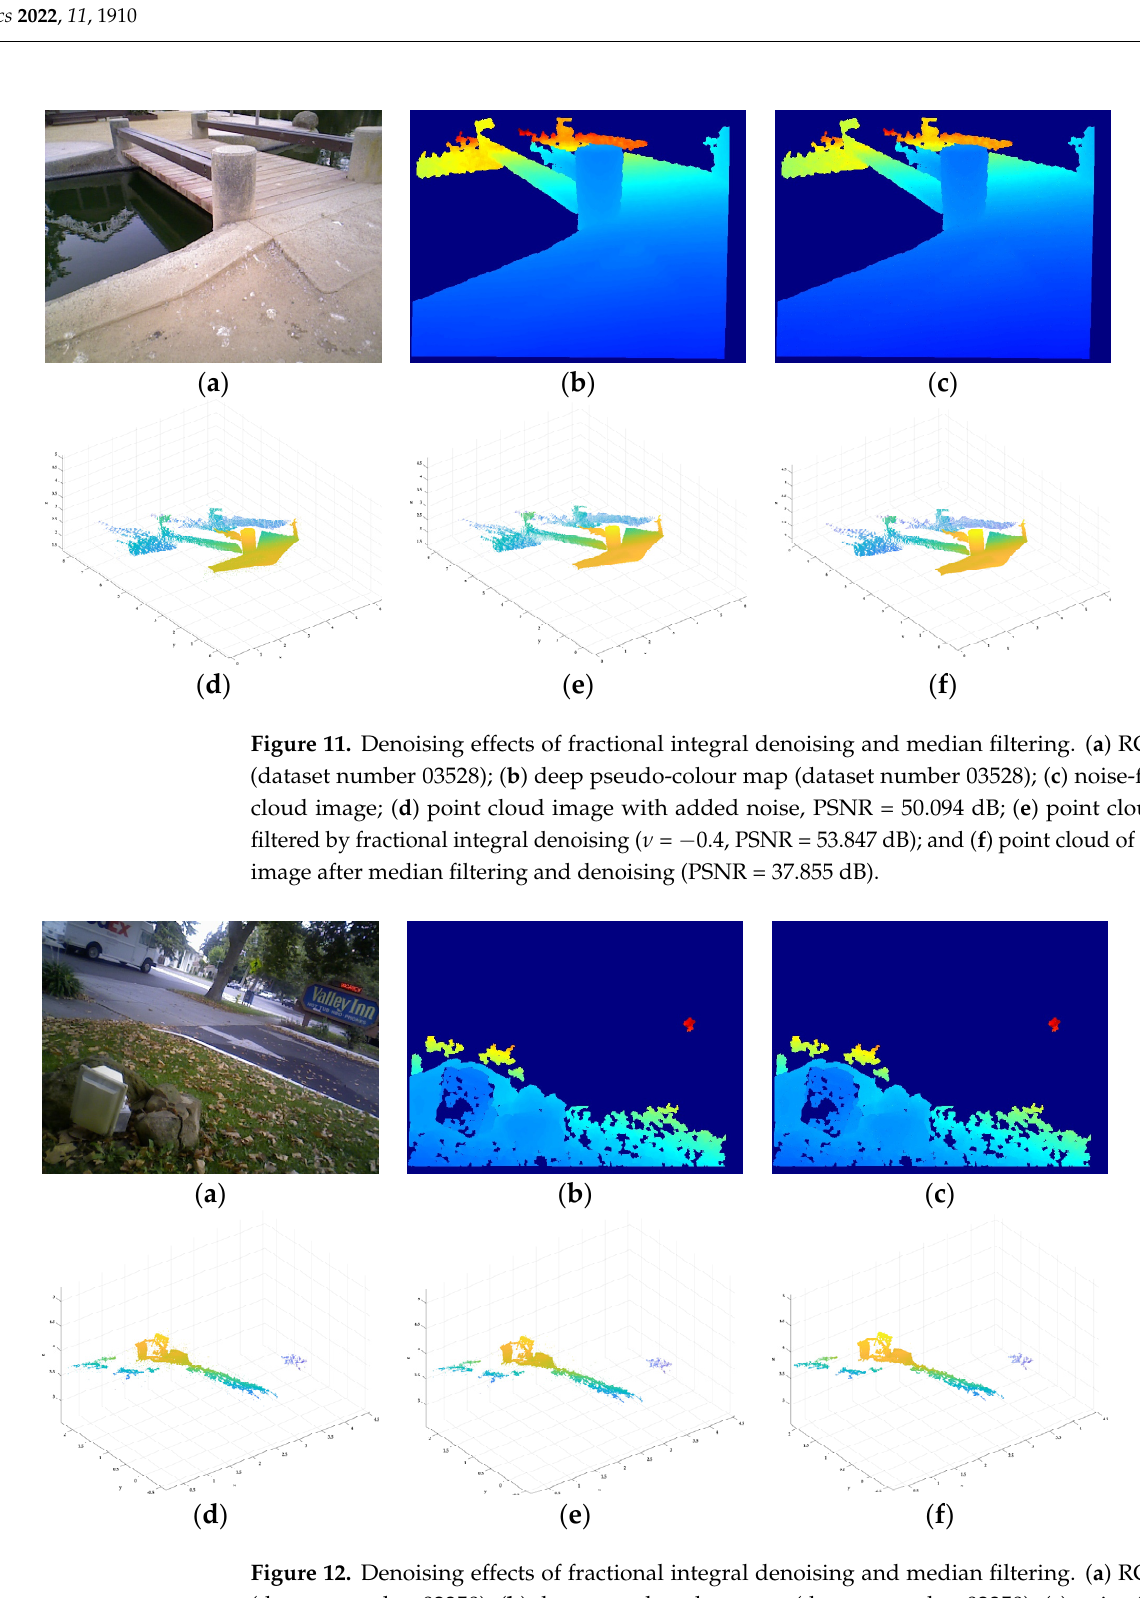
(dataset number 02350); ( b ) deep pseudo-colour map (dataset number 02350); ( c ) noise-free point cloud image; ( d ) point cloud image with added noise, PSNR = 54.611 dB; ( e ) point cloud image filtered by fractional integral denoising ( ν = − 0.3, PSNR = 57.391 dB); and ( f ) point cloud of the depth image after median filtering and denoising (PSNR = 36.309 dB).